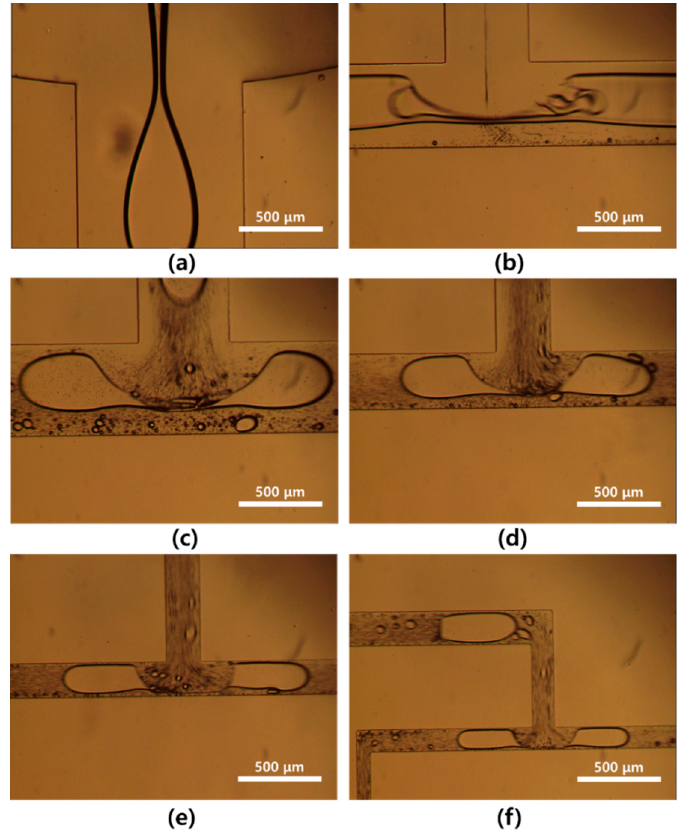
Figure 4. Optical images of ( a ) a water droplet at the orifice and ( b – f ) division of water droplets from the first T-junction to the fifth T-junction in the 512-channel geometrical passive breakup device.